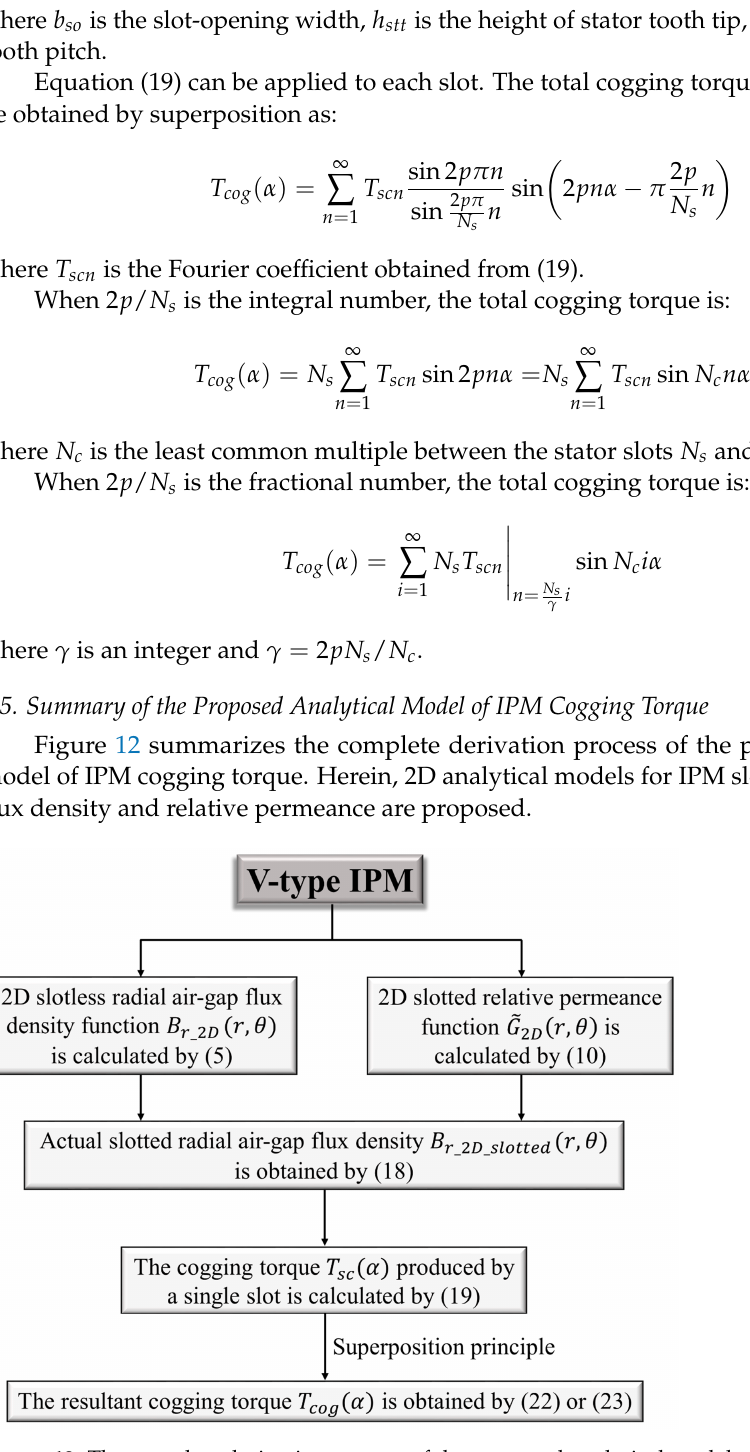
Figure 12. The complete derivation process of the proposed analytical model of IPM cogging torque.